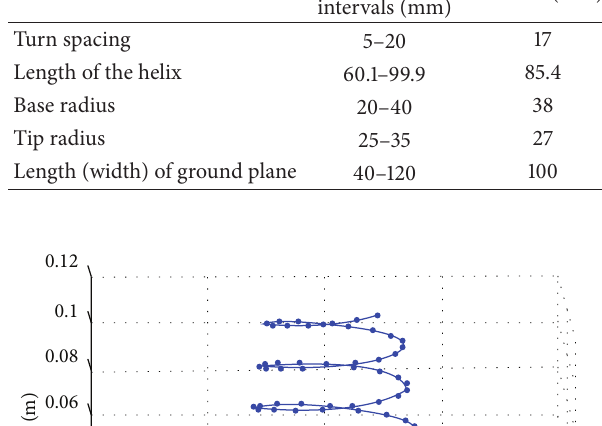
Figure 6: Implementation of the proposed circular switched para- sitic array with SuperNEC.